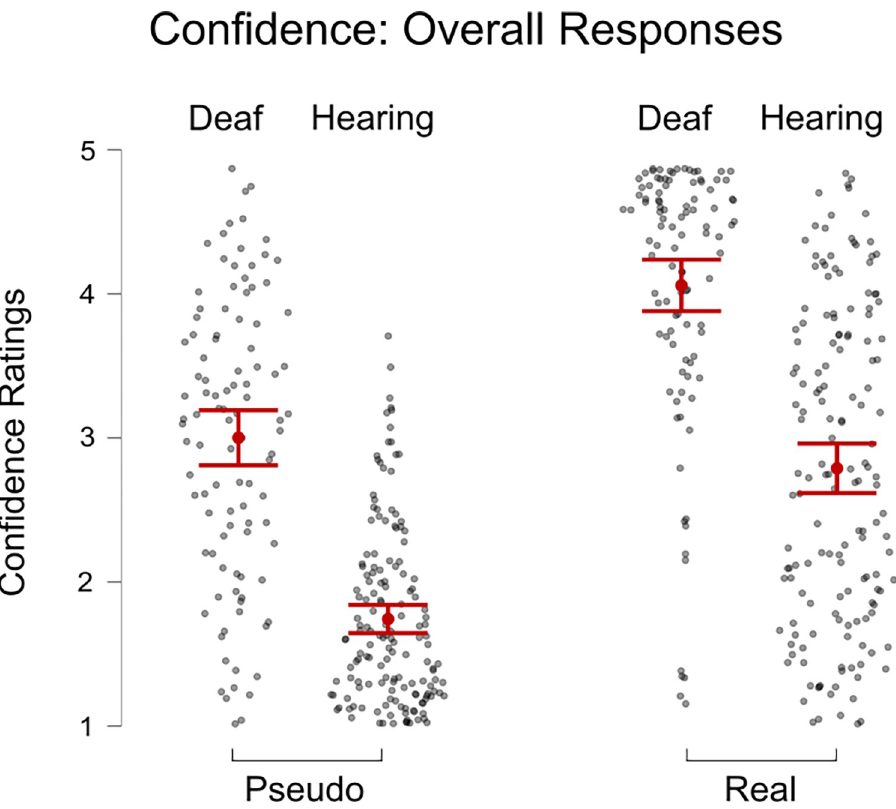
Fig 4. Overall mean confidence of responses to pseudo names compared to real names for deaf and hearing groups. The error bars on the Fig show standard error.